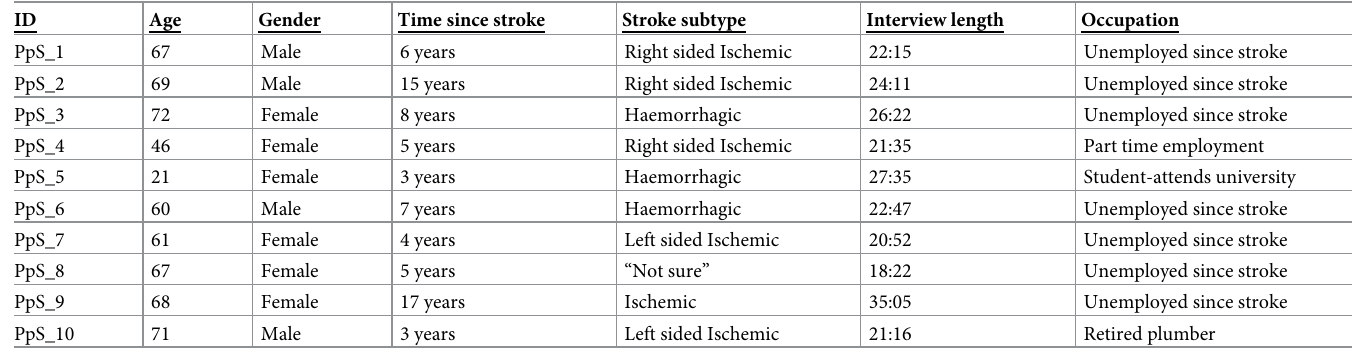
Table 2. Participant demographics: Caregivers (n = 5).